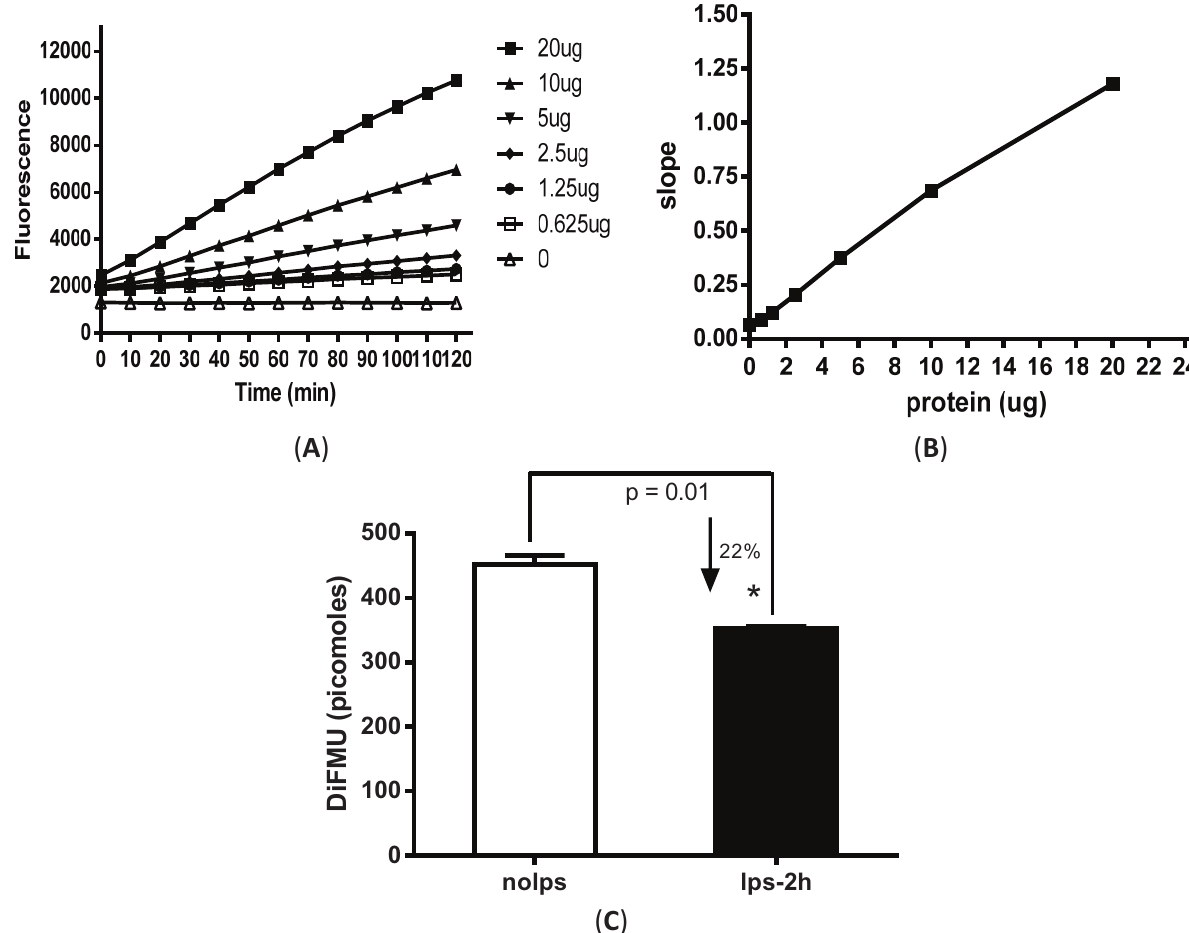
Figure 1. Fluorescence-based phosphatase assay in LPS-stimulated peritoneal macrophages. Elicited peritoneal macrophages were harvested from C57BL6 mice at day 4 after thioglycollate injection. Cells were lysed with imidazole buffer and protein concentration was measured by BCA assay. ( A ) Time-course and dose-dependent responses measured from total cell lysates in buffers containing non-fluorescent substrate DiFMUP and NiCl 2 additive. Y-axis shows the fluorescence reading as random light units; ( B ) Slope reaction. Slope value represents reaction rates which are calculated by dividing the changes of enzyme activity by time (from kinetic reaction). Assay kinetic was set from 0 to 120 min with an interval value of 10 min; ( C ) Down-regulation of phosphatase activity in LPS-stimulated macrophages (100 ng/mL LPS for 2 h). Absolute value of DiFMU on the Y-axis was calculated based on DiFMU standard curve. * p = 0.01 as compared to non-LPS treated